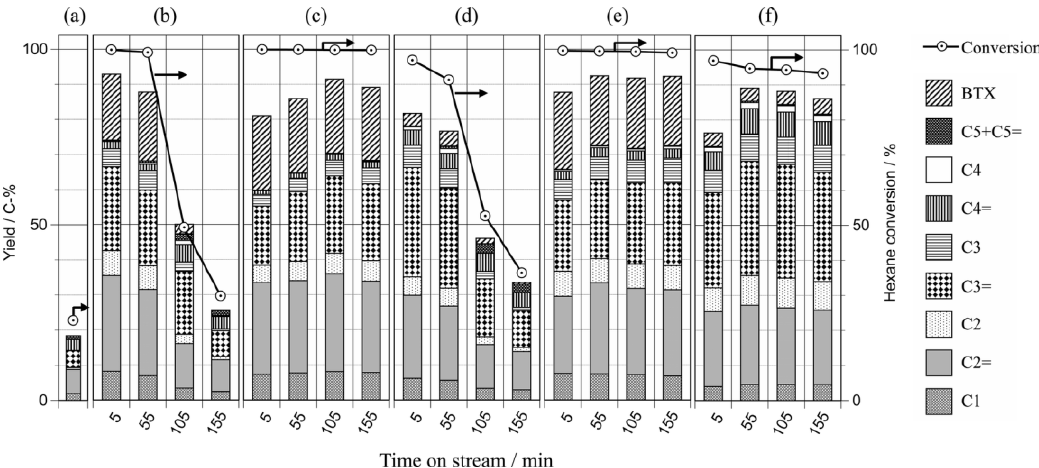
Figure 17. The conversion of hexane and product yields in hexane cracking at 650 °C over various ZSM-5 catalysts: ( a ) no catalyst; ( b ) parent ZSM-5; ( c ) acid-treated ZSM-5 micron; ( d ) milled ZSM-5; ( e ) milled and recrystallized ZSM-5; and ( f ) milled, recrystallized and acid-treated ZSM-5 [111]. Copyright Royal Society of Chemistry, 2015.